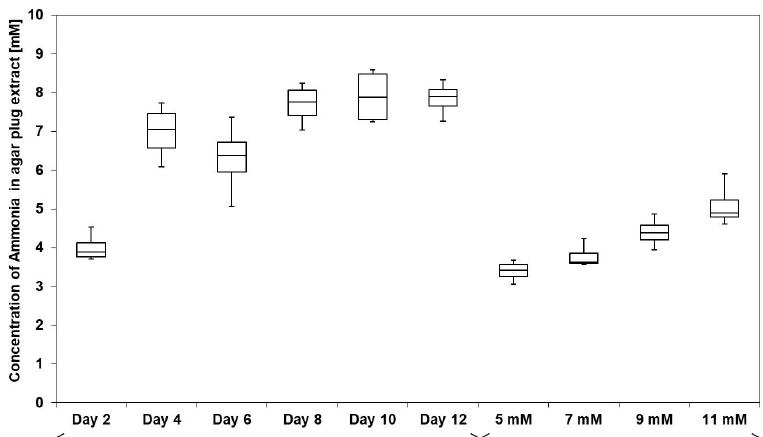
Figure 3. Box plot diagram showing the amount of ammonia released by Streptomyces sp. Av25_4 after 2, 4, 6, 8, 10, and 12 d in the agar plug of the PDA medium of the E. weberi compartment. Ammonia in the PDA agar plug of the E. weberi compartment after supplementation of ammonia (5, 7, 9, and 11 mM). The whiskers represent the minimum and maximum values and the segment inside the rectangle shows the median values (four biological replicates).